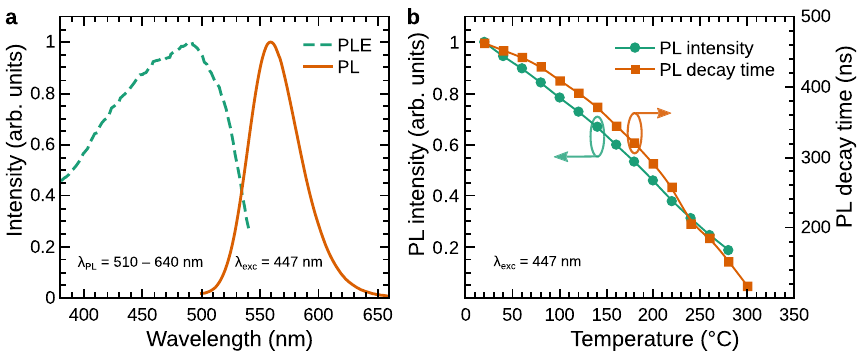
2 + Figure 1. PL properties of the Eu activated chalcogenide phosphor BUVY02. ( a ) The PL (solid orange) and PLE (dashed green) spectra. The PLE excitation was evaluated integrating PL spectra between 510 and 640 nm, the PL was recorded under a blue LED excitation (peak wavelength 447 nm). ( b ) The PL intensity (green circles) and PL decay time (orange squares) thermal quenching curves.